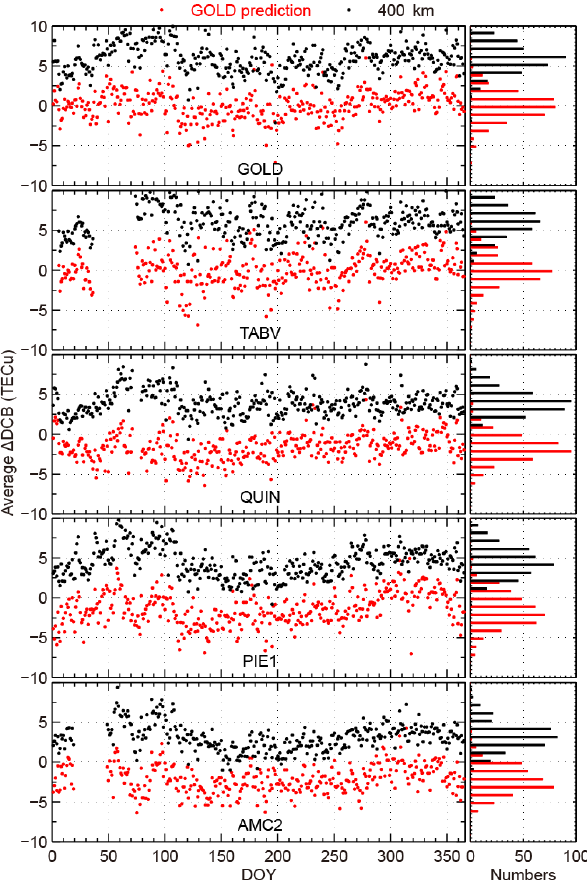
Figure 4. Comparisons of the average (cid:49) DCB calculated using the predicted optimal ionospheric shell heights (red dots) and those us- ing the fixed ionospheric shell height (black dots) in 2014 for sta- tions in Region